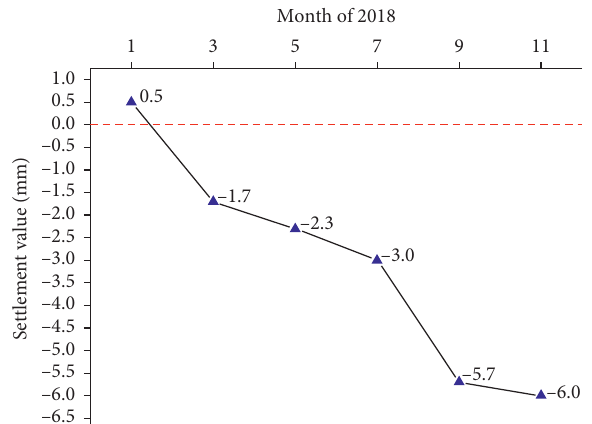
Figure 33: Ground settlement value 0.1m away from the edge of the foundation pit in 2018.